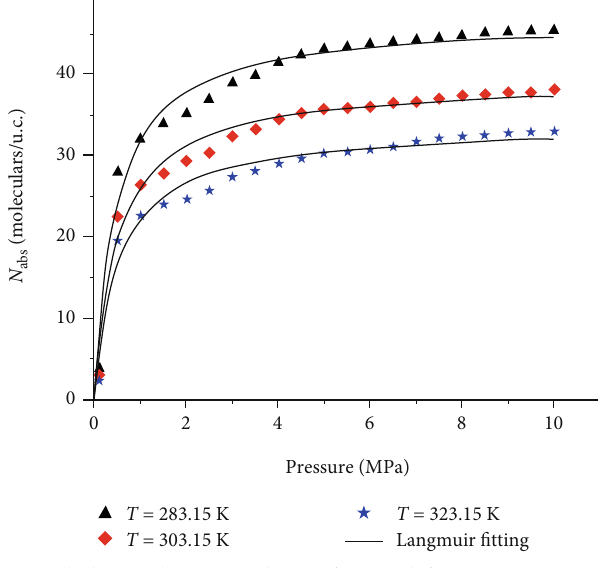
Figure 9: The lignite adsorption isotherms of CH